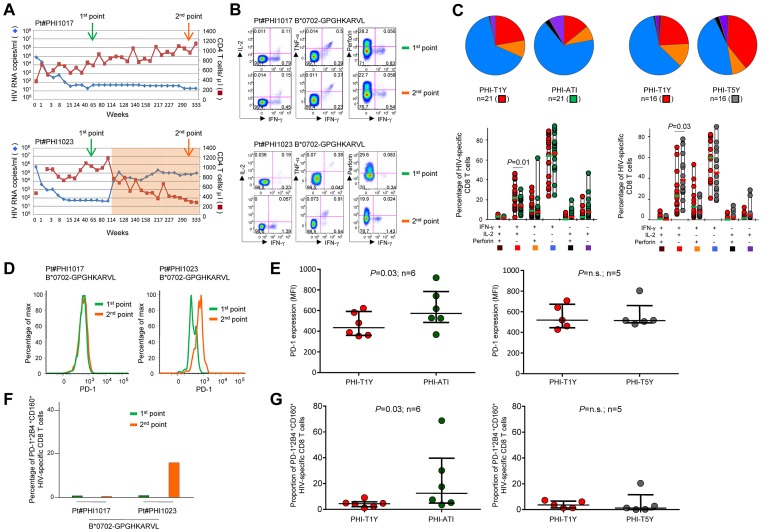
Qualitative changes of HIV-specific CD8 T cells in patients experiencing a virus rebound following treatment interruption.
A. Longitudinal analysis of the CD4 T-cell counts and HIV viremia of 2 representative HIV-infected patients (#1017 and #1023) treated with ART since acute infection. Patient #1017 remained on ART, whereas patient #1023 spontaneously interrupted ART after 119 weeks (orange box). B. Functional profiles of B*0702-GPGHKARVL-specific CD8 T cells from patients #1017 and #1023 analyzed at two distinct time-points corresponding to weeks 48 and 300 (identified by the arrows in A). C. Cumulative analysis of the functional profile of HIV-specific CD8 T-cell responses on the basis of the expression of IFN-γ, IL-2 and perforin in patients with acute (PHI) infection after one year of ART (-T1Y) and after either treatment interruption (-ATI) or after five years of ART (-T5Y). Matched-paired HIV-specific CD8 T-cell responses are considered for the comparison between T1Y and ATI or between T1Y and T5Y. Although TNF-α was also detected, analysis is restricted to the expression of IFN-γ, IL-2 and perforin for clarity. All possible combinations of IFN-γ, IL-2 and perforin are shown on the x axis, whereas the percentages of the distinct cell subsets within HIV-specific CD8 T cells are shown on the y axis. The pie charts summarize the data, and each slice corresponds to a certain combination of functions. Colors in the pie charts are based on the colored boxes at the bottom of the panel. D. PD-1 expression in B*0702-GPGHKARVL-specific CD8 T cells in patients #1017 and #1023 measured at the two time-points identified with arrows in A. E. Mean fluorescence intensity (MFI) of PD-1 expression in HIV-specific CD8 T cells measured in patients with acute (PHI) HIV infection after 1 year of ART (-T1Y) and after either treatment interruption (-ATI, left panel) or after five years of ART (-T5Y, right panel). F. Proportion of PD-1+2B4+CD160+ cells in B*0702-GPGHKARVL-specific CD8 T cells in patients #1017 and #1023 measured at the two time-points identified with arrows in A. G. Proportion of PD-1+2B4+CD160+ cells in HIV-specific CD8 T cells measured in patients with acute (PHI) HIV infection after 1 year of ART (-T1Y) and after either treatment interruption (-ATI, left panel) or after five years of ART (-T5Y, right panel).